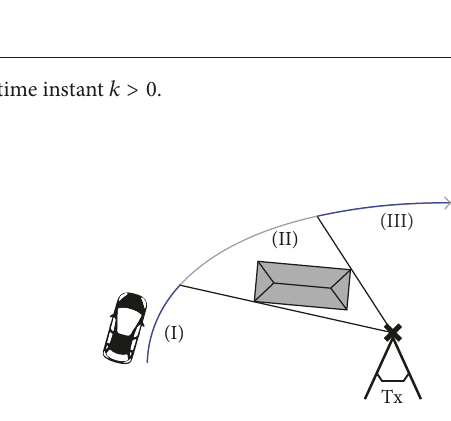
Figure 5: A user moves along the trajectory. The LoS signal to the transmitter in Region (I) is lost in Region (II) temporarily due to blocking by an obstacle and received again in Region